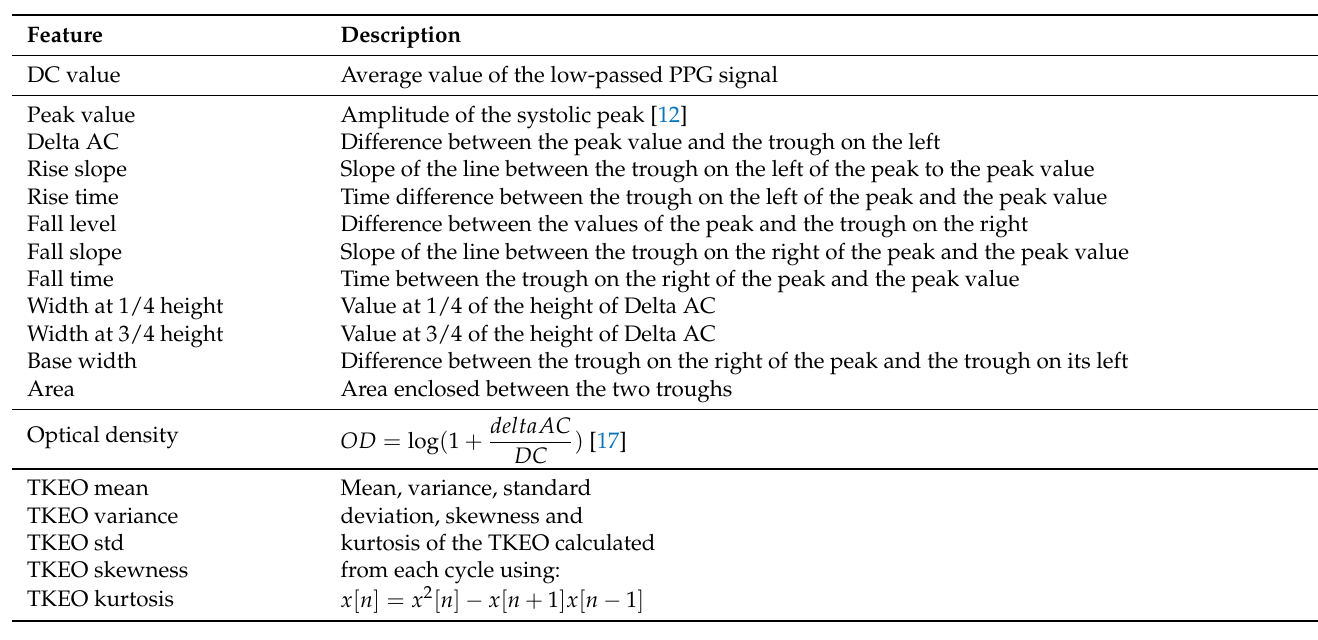
Table 2. Summary of features extracted from each PPG